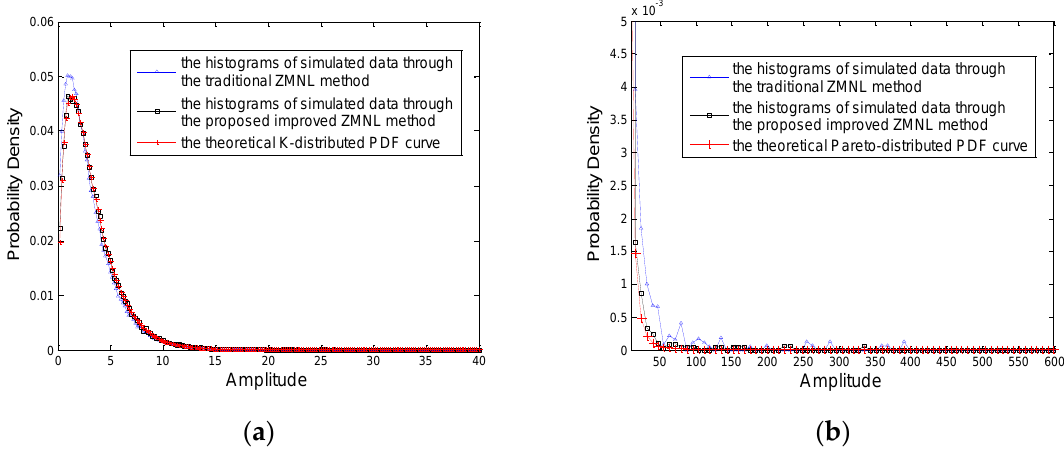
Figure 6. Theoretical PDF and averaged histogram of the simulated data generated by the traditional ZMNL and the proposed improved ZMNL methods. ( a ) K distribution; ( b ) Pareto distribution.